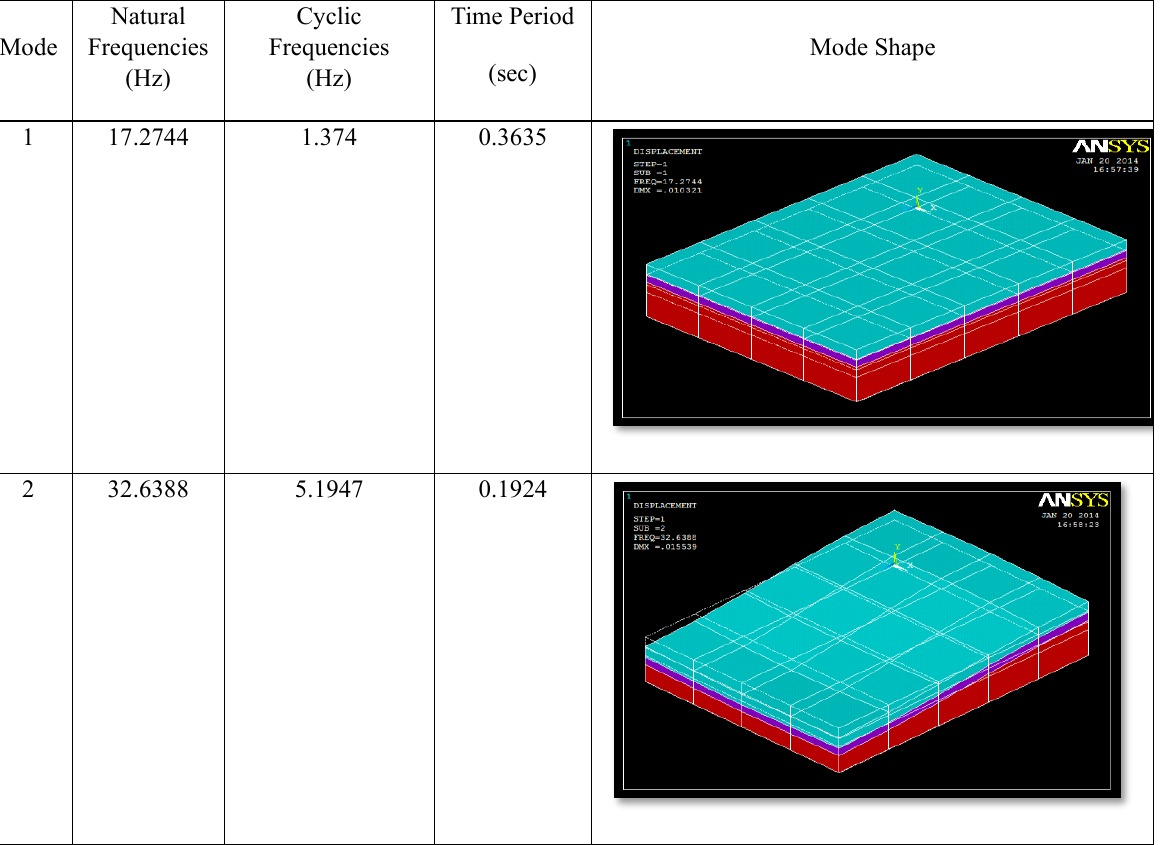
Mode shape for airfield pavement considering 6 d.o.f